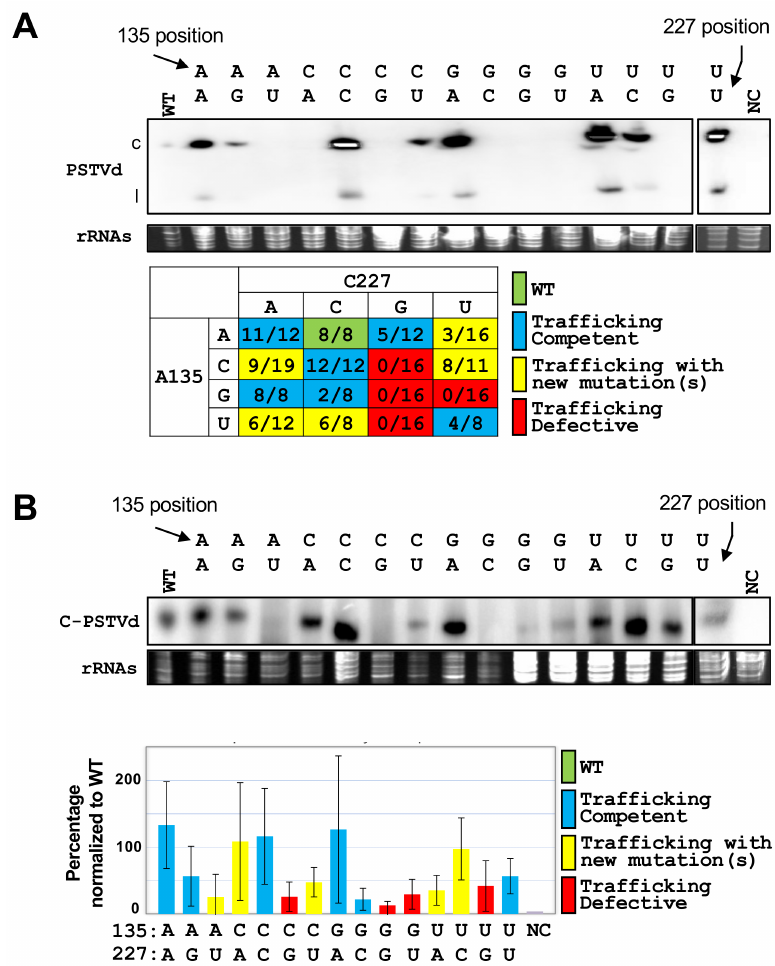
Figure 1. Saturated mutational analyses revealing the functional loop 19 variants of PSTVd. ( A ) Northern blots showed the accumulation of functional loop 19 variants accumulated in systemic leaves in one infection. Each variant was inoculated with at least eight biological replicates, and the data were summarized in the table. c, circular PSTVd. l, linear PSTVd; ( B ) One of the triplicated Northern blots showed the accumulation of progeny from the replication of loop 19 variants in inoculated